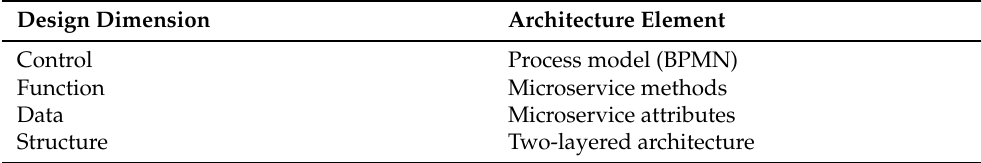
Table 1. Mapping of dimensions to development